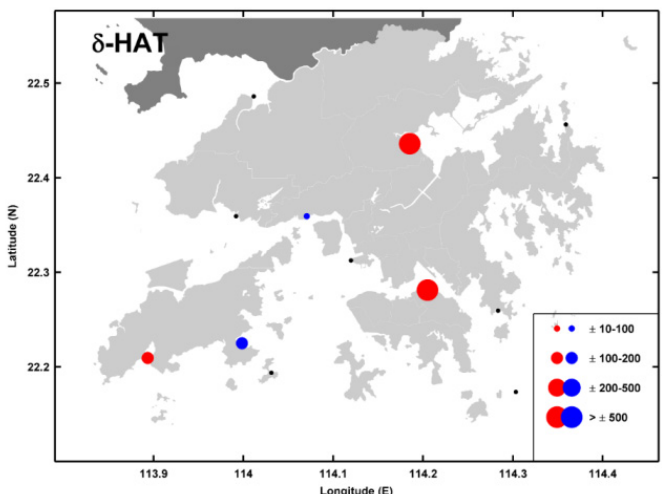
Figure 11. The tidal anomaly correlation computed from the combination of the four largest tidal constituent amplitudes (given by the detrended sum of the M2 + S2 + K1 + O1) as a proxy for the change in the approximate highest astronomical tide ( δ -HAT) relative to detrended MSL in Hong Kong, with the marker size showing the relative magnitude according to the legend, in units of mm m-1. Red/blue markers indicate positive/negative TACs, and black markers indicate TACs that are not significantly different from zero (refer to